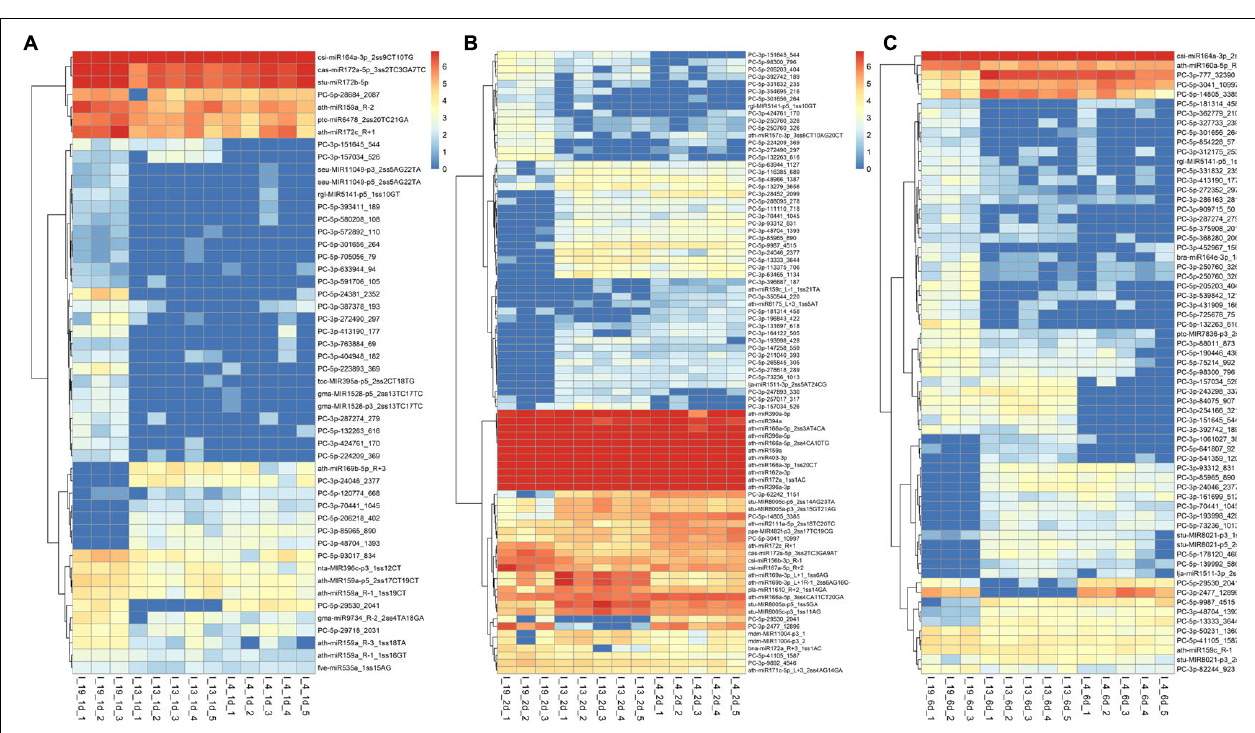
( Figure 3B and Supplementary Table 3 ). Micro RNAs